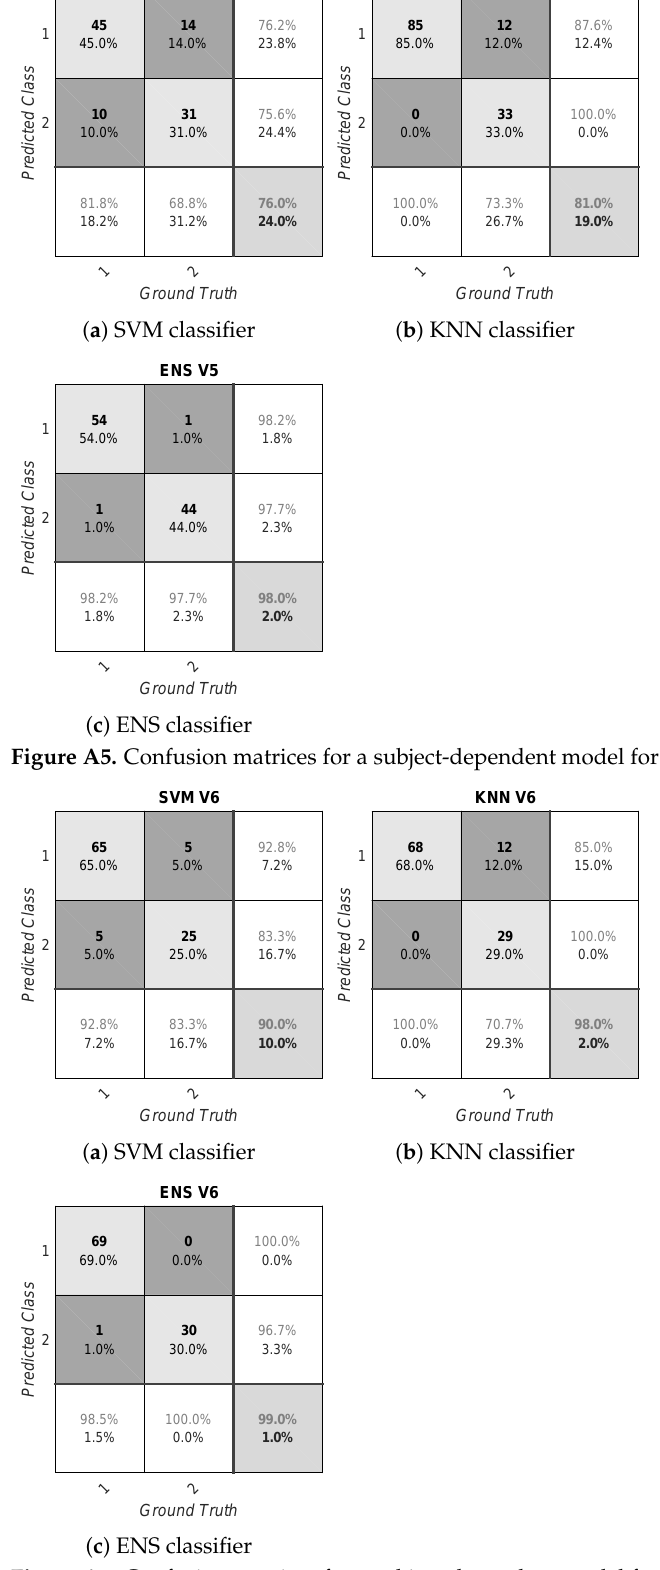
Figure A6. Confusion matrices for a subject-dependent model for